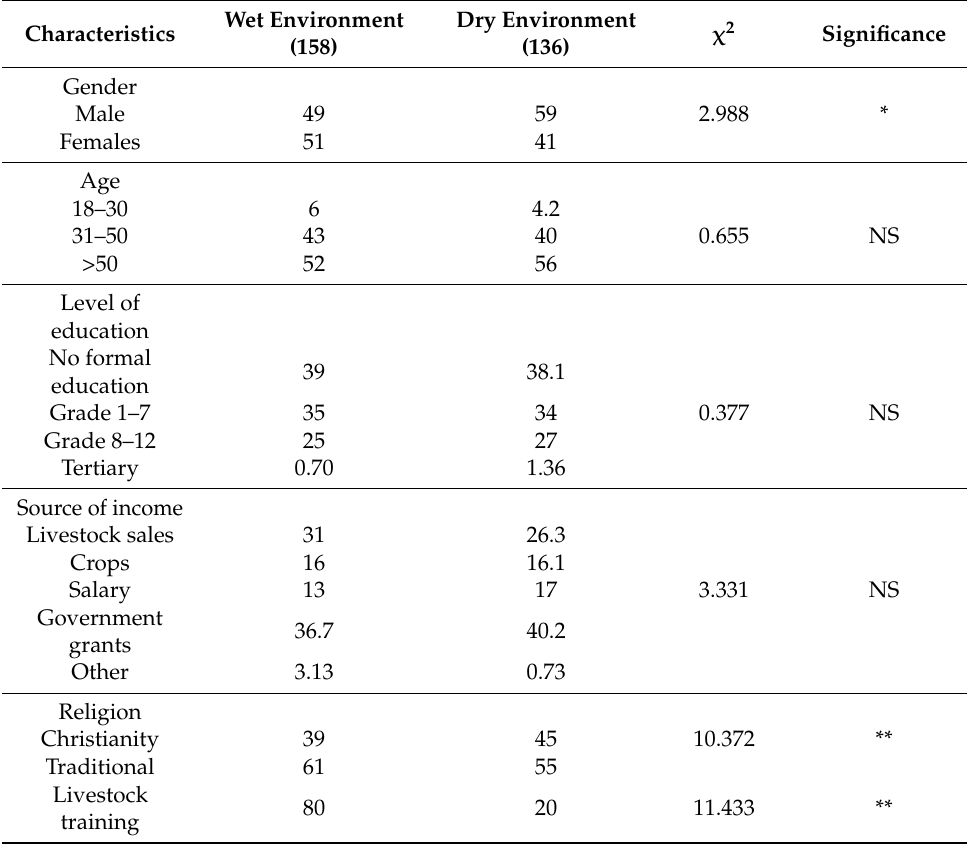
Table 1. Household demographic information of farmers participating in the study.